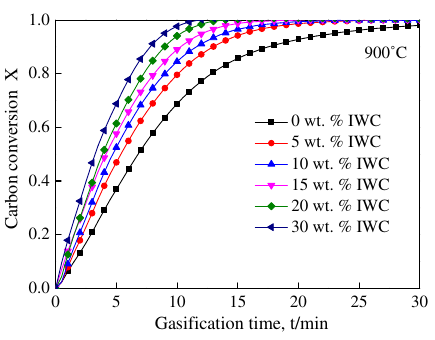
Fig. 4 Different IWC loading ratio on YCW gasification reactivity at 1000